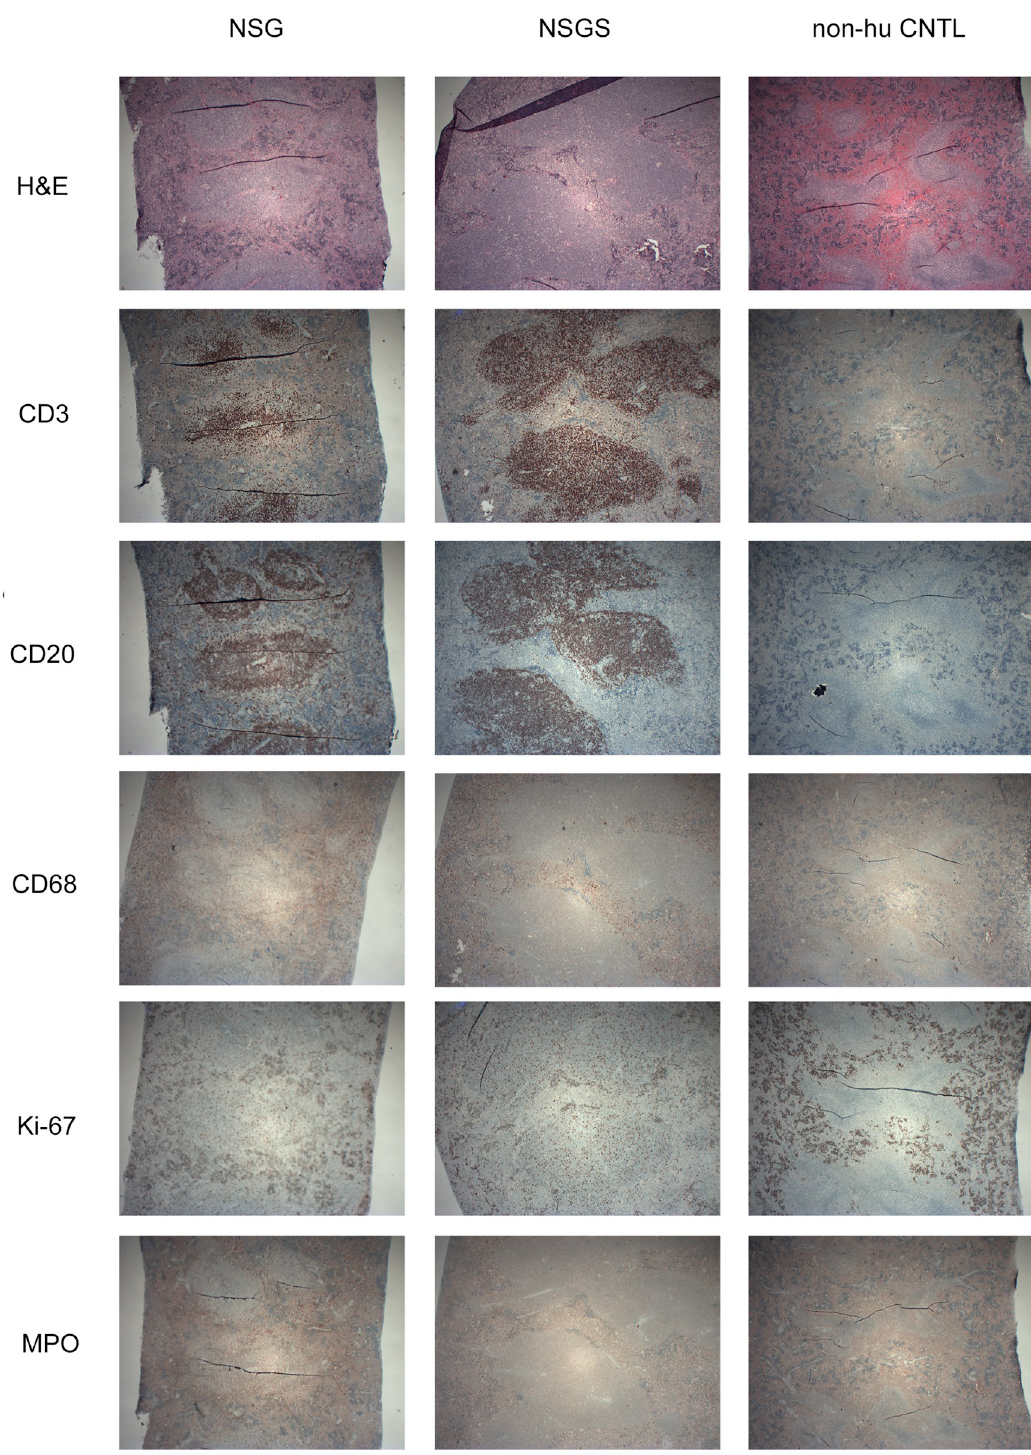
Fig 8. Humanized NSGS mice exhibit proper splenic organization. H&E or the indicated antibody stains were performed on formalin fixed spleen tissue from long term engrafted mice (16 weeks).